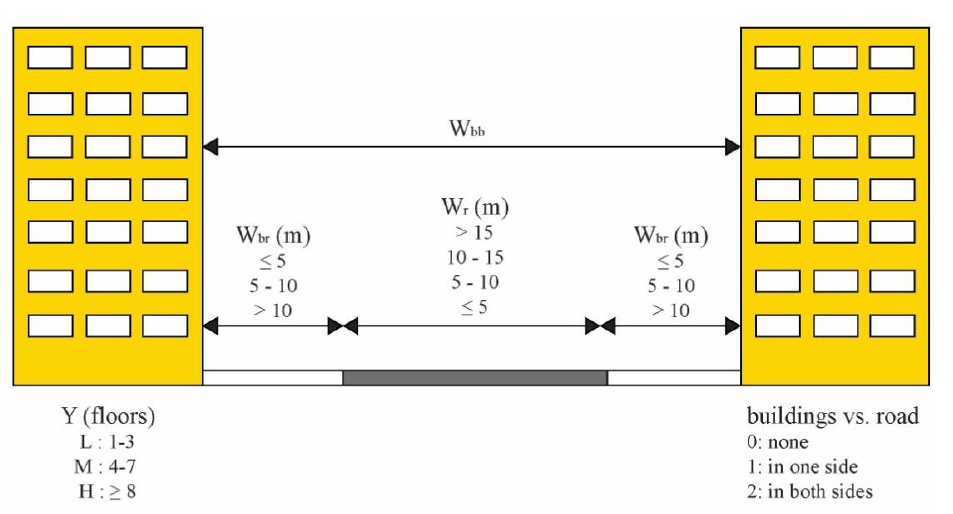
Figure 7. Features of urban roads for their typological description versus building collapse.